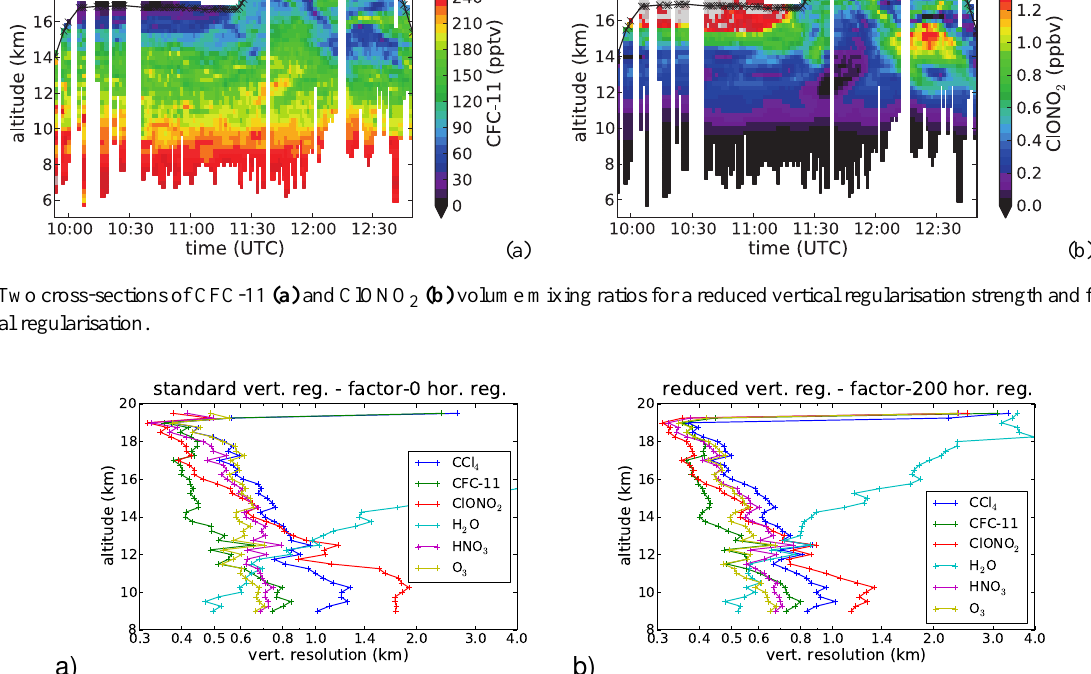
Fig. 12. Vertical resolution of selected retrieval targets for a representative profile (12:30UTC) for the baseline setup in panel (a) and a reduced vertical regularisation strength and factor-200 horizontal regularisation in panel (b) .